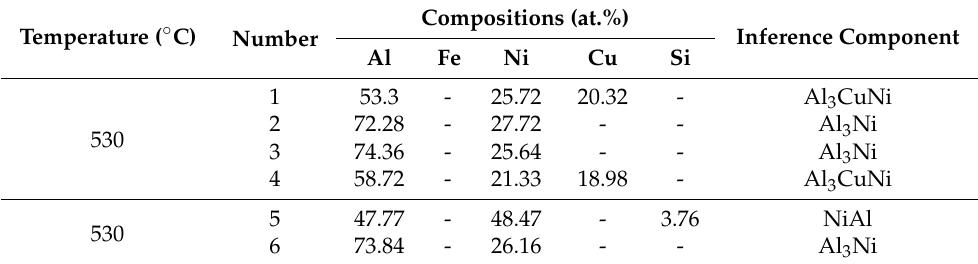
Table 3. The qualitative analysis of the intermetallic layer corresponding to the points in Figure